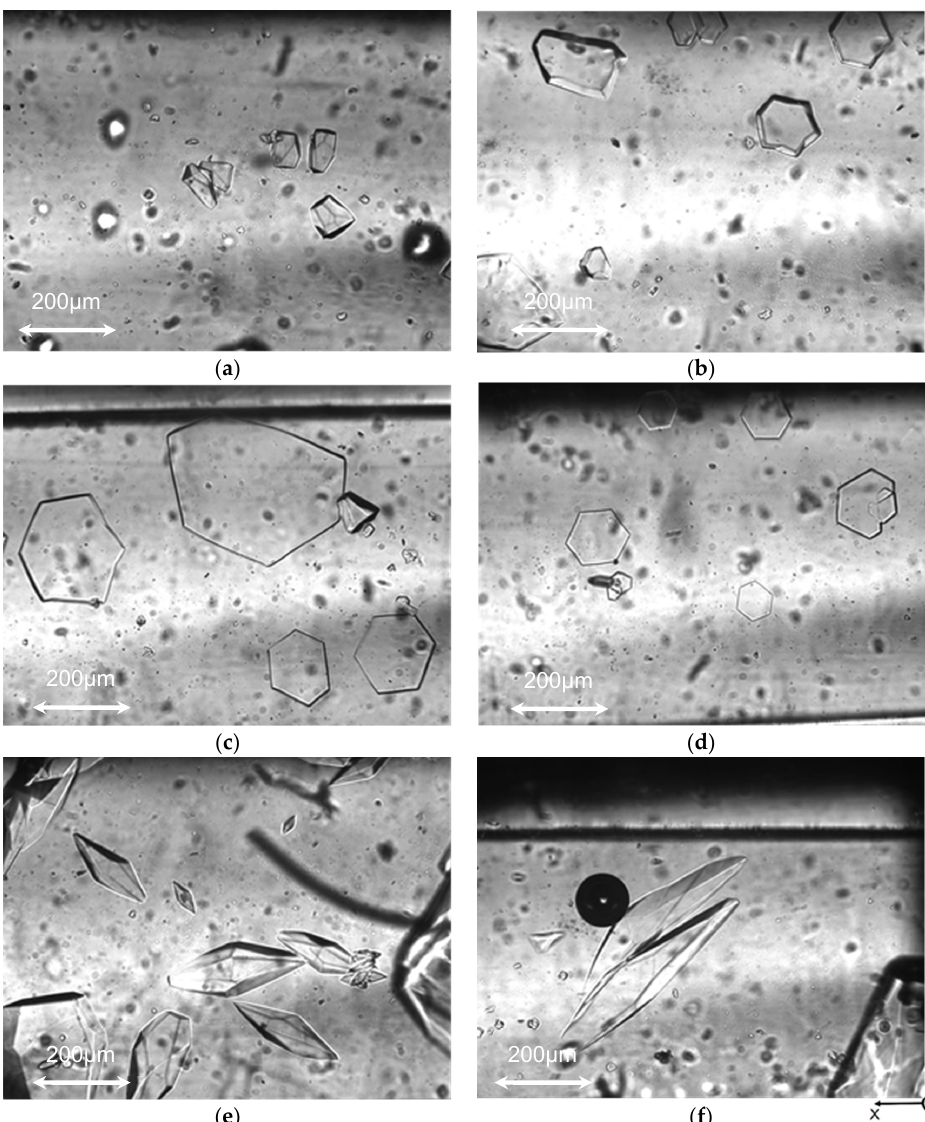
Figure 7. Shapes of typical ice particles in the quiescent ice slurry. ( a ) In the case of filtrate. Molecular weight limit was 10 5 ; ( b ) In the case of filtrate. Molecular weight limit was 10 5 ; ( c ) In the case of concentrate. Volume was one-tenth. Molecular weight limit was 10 5 ; ( d ) In the case of concentrate. Volume was one-tenth. Molecular weight limit was 10 4 ; ( e ) In the case of concentrate. Molecular weight limit was 10 5 ; ( f ) In the case of concentrate. Molecular weight limit was 10 4 . A black circle in this figure is the shadow of a micro bubble in the channel, which did not affect the motion of ice particles significantly.